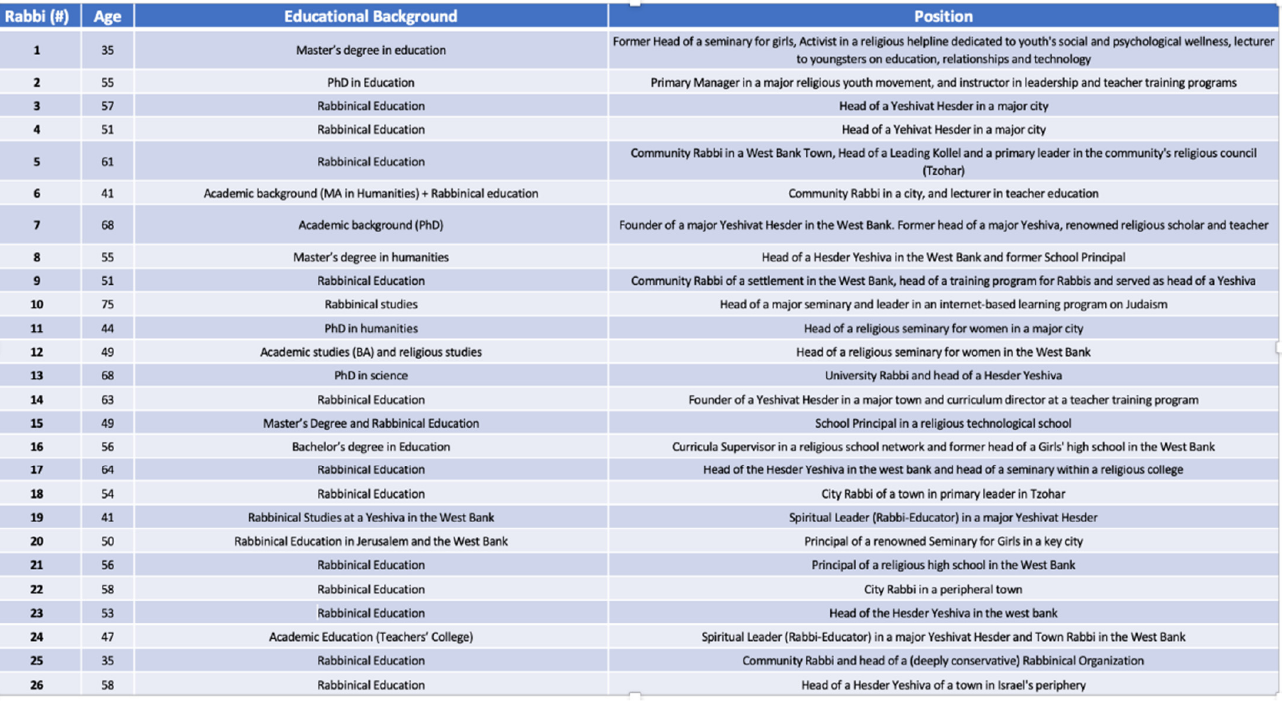
Figure A1. List of sampled Rabbinical interviewees by age, educational background and current position.